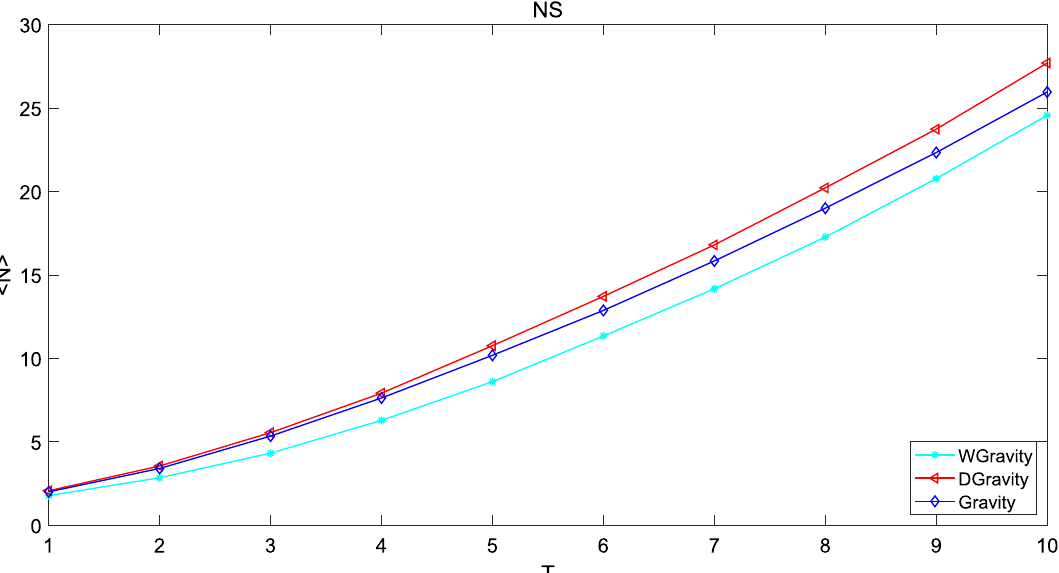
Figure 13. This figure compares the new model with Gravity model and weighted gravity model based on average infected nodes in network NS.The growth rate increase with time. Obviously, the new model is superior to Gravity model and weighted gravity